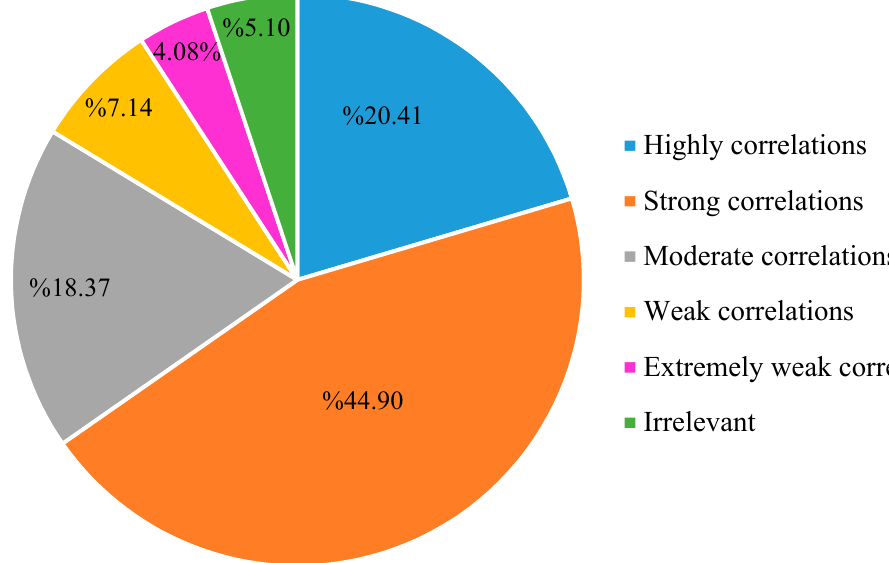
Figure 12. Proportion of the different correlation coefficients between the unstructured data and the measured rainfall data.